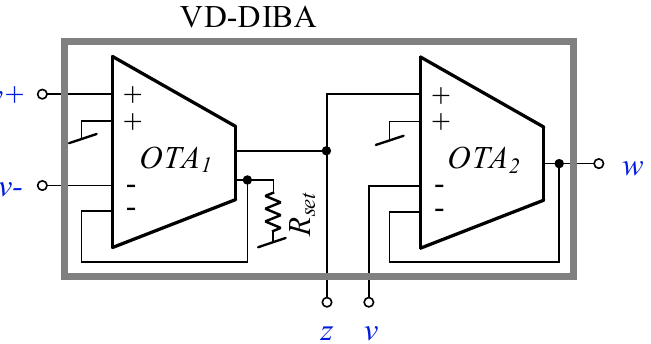
Figure 3. The VD-DIBA based on a multiple-input operational transconductance amplifier (OTA).